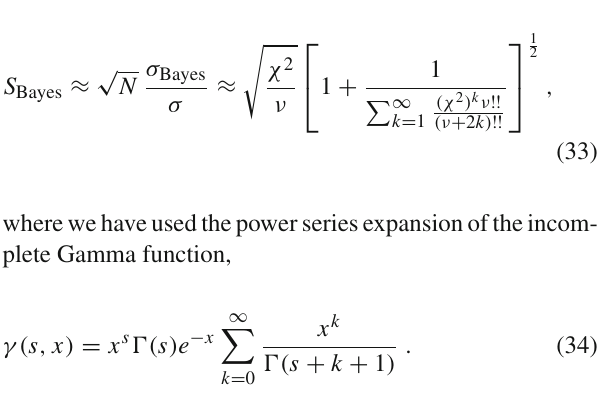
Fig. 6. The red point denotes the ordinary weighted average with PDG scaling applied, and is pulled away from the hor- izontal line as a result of the deviating 11th